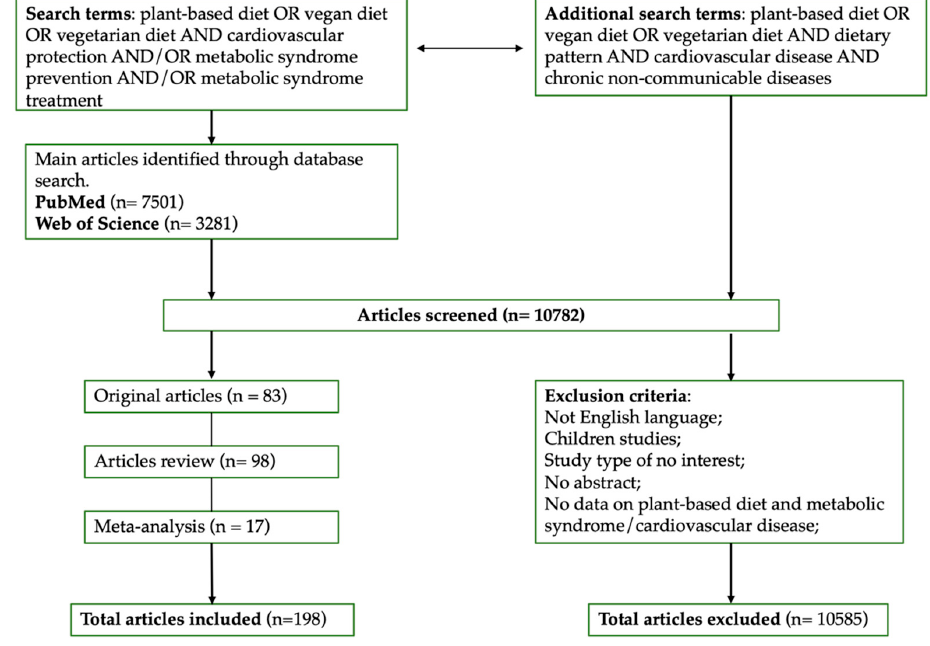
Figure 2. Full search strategy.